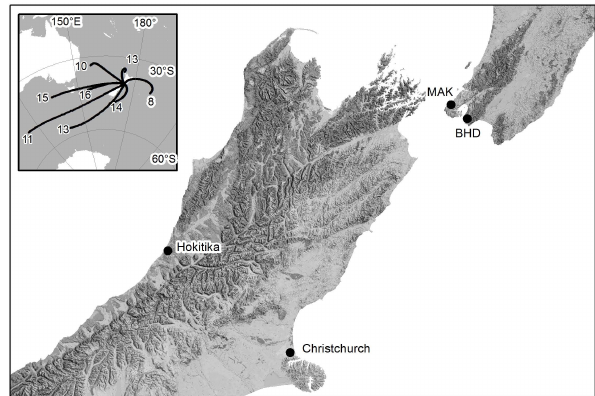
Fig. 1. Map showing the location of Baring Head station (BHD) and Makara (MAK) in the North Island. The South Island mountain range between Hokitika and Christchurch allows for the identifi- cation of atmospheric pressure differentials that ensure air arriving at Baring Head has not been in contact with the South Island land mass. The inset map shows clustered results of 20yr of twice daily 4-day back-trajectory calculations, with percentages indicated for each